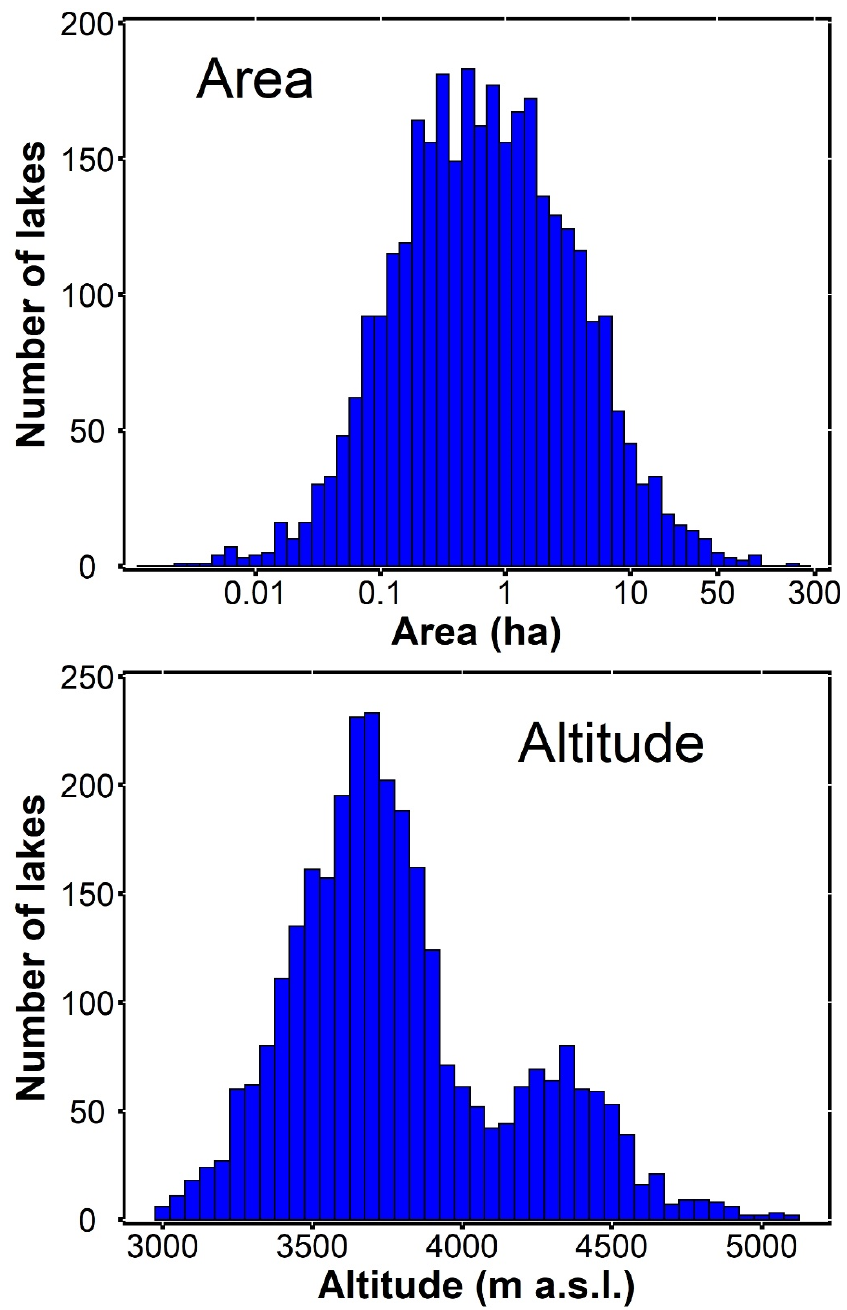
Figure 2. Area and altitude distributions of the Colombian páramo